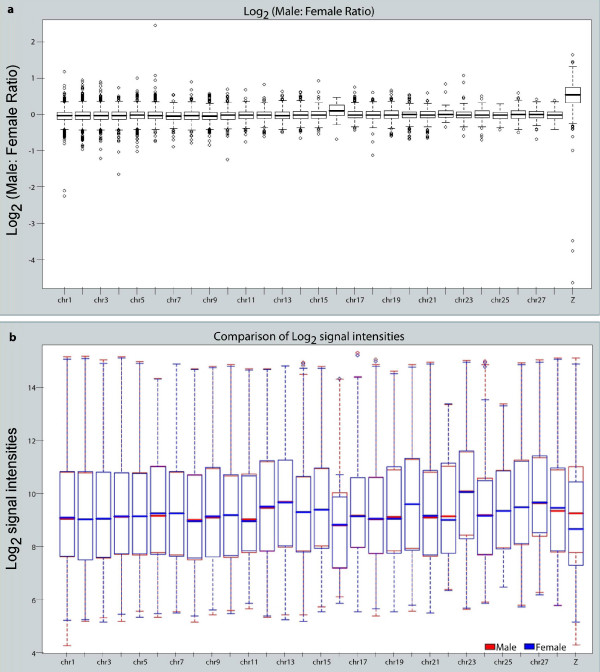
Comparison of M:F ratios and expression levels of Z-linked genes to those of autosomal genes. (a) The average values of M:F ratios for autosome chr1-chr28, along with that of Z chromosome. Values are represented on log2 scale. (b) The distribution of the expression level of genes on autosome chr1 to chr28 and on chrZ in female (blue) and male (red). Values are represented on log2 scale. For simplicity, the W chromosome is not included. Chromosome 32 is not annotated and thus not included in this analysis.